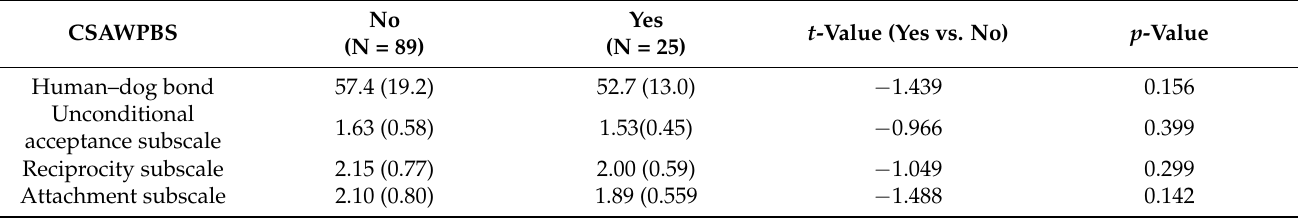
Table 3. Participant–dog bond according to pet ownership.